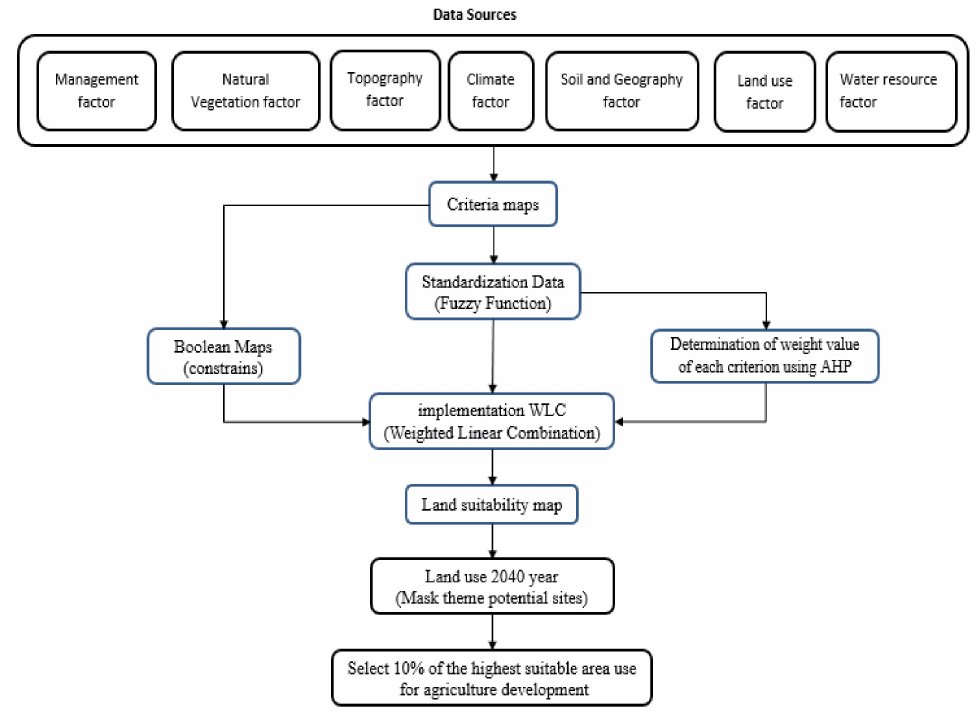
Figure 2. Schematic diagram of land use suitability for agriculture development in the watershed Tajan,